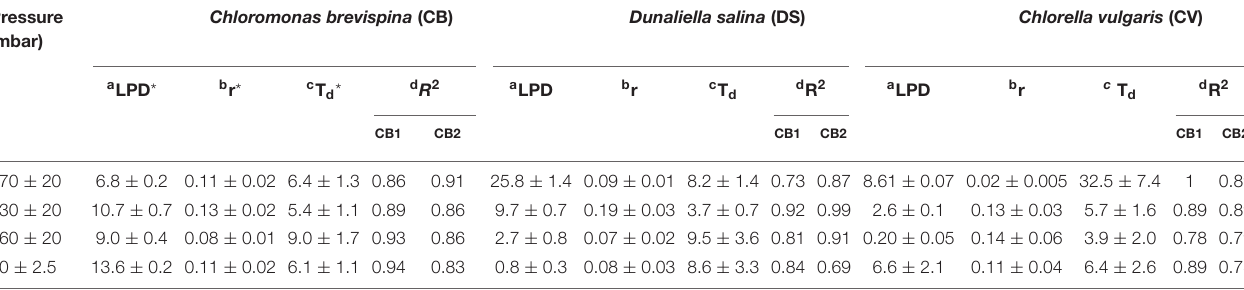
TABLE 3 | Estimated Lag Phase Duration (LPD), growth rate (r), doubling time (T d ), and correlation coefficient ( R 2 ) value for the candidate algae at different pressures. Pressure Chloromonas brevispina (CB) Dunaliella salina (DS) Chlorella vulgaris (CV) (mbar)